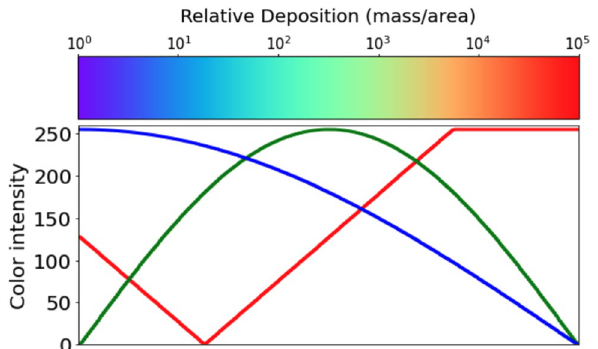
Figure 2. Red, green, and blue (RGB) values and their corresponding magnitude of deposition for the Python rainbow colormap used to plot the images used for training purposes.